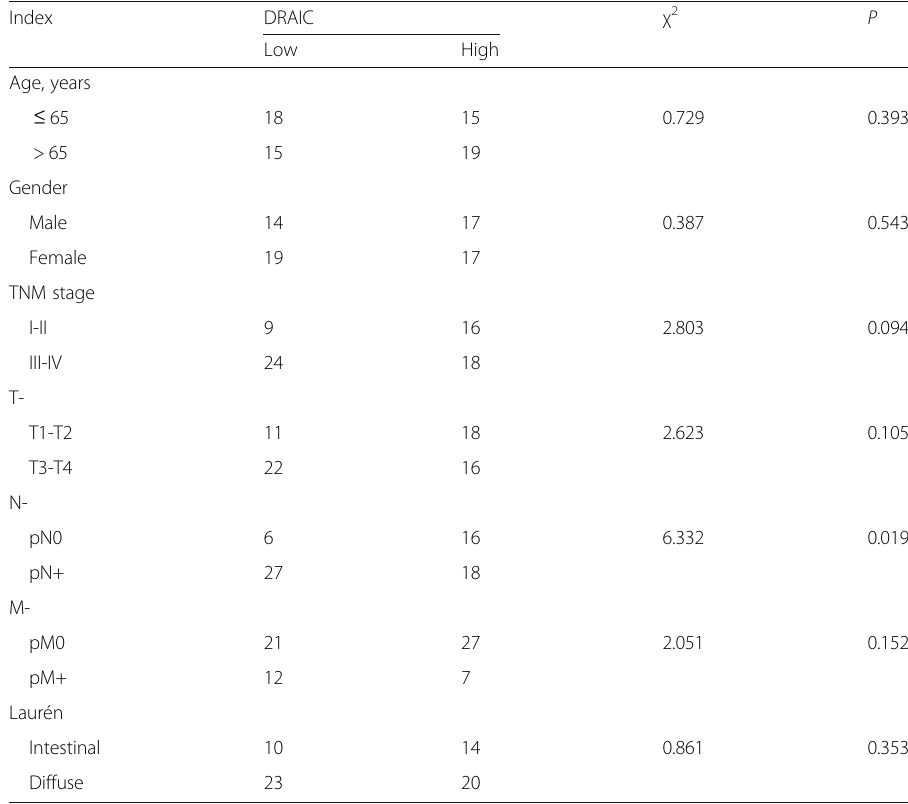
Table 1 Association of DRAIC with clinicopathological variables in GC